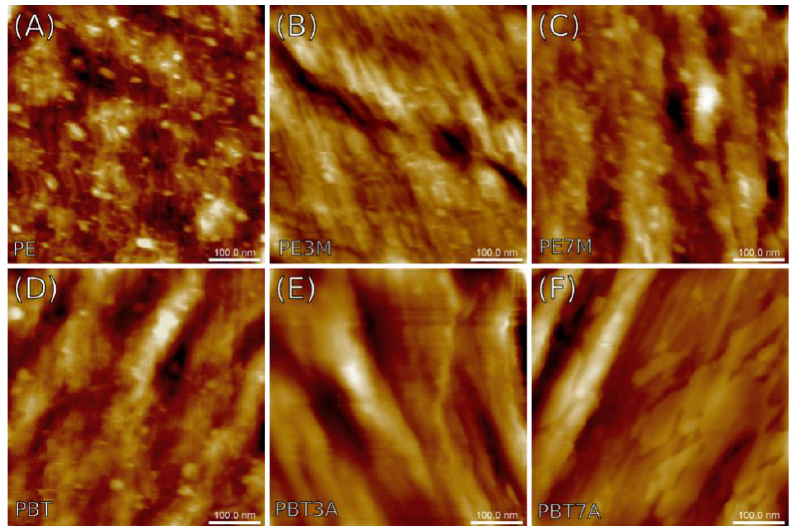
Figure 8. The AFM topographical images of the composites taken from metallographic microsections. Samples: ( A ) PE; ( B ) PE3M; ( C ) PE7M; ( D ) PBT; ( E ) PBT3A; ( F ) PBT7A.